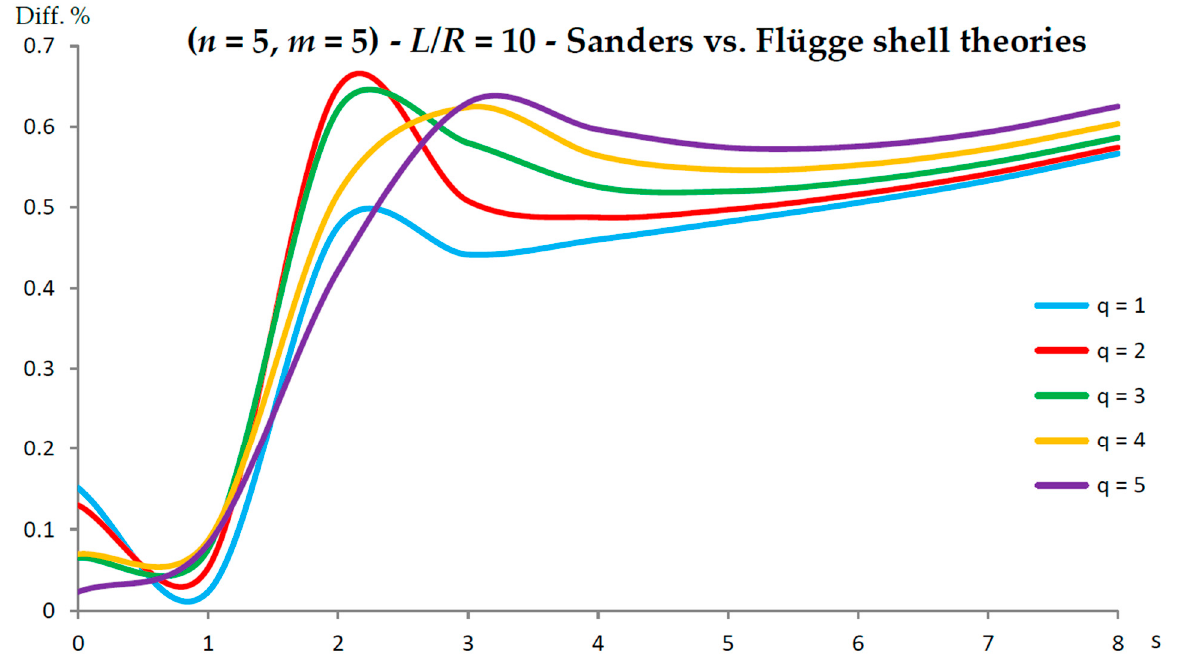
Figure 3. Percentage differences between the radial natural frequencies obtained via Sanders and Flügge shell theories (Flügge as the reference). Anisotropic elastic shell model. Simply supported SWCNT of Table 1 with chirality indices ( n = 5, m = 5 ) and aspect ratio L / R = 10. Number of longitudinal half-waves q . Number of circumferential waves s .